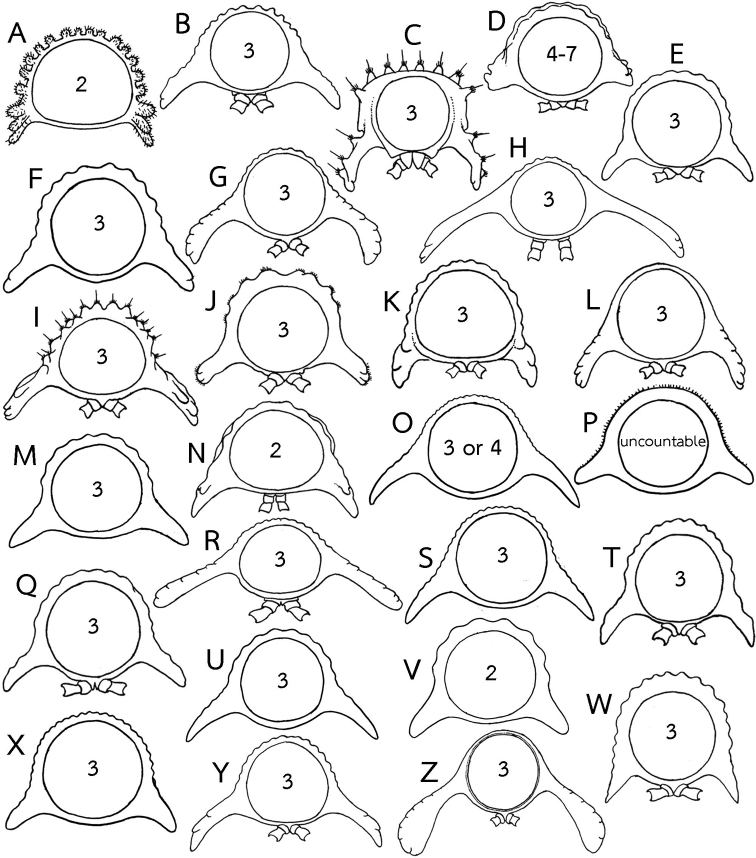
Body ring (posterior view) in several Eutrichodesmus species, number inside ring indicates rows of tubercles on metaterga. All species without mid-dorsal projections on metaterga AE.
elegansBE.
filisetigerCE.
gremialisDE.
griseusEE.
incisusFE.
jianjiaGE.
latellaiHE.
latusIE.
monodentusJE.
multilobatusKE.
nadanLE.
obliteratusME.
parvusNE.
peculiarisOE.
planatusPE.
reductusQE.
regularisRE.
similisSE.
simplexTE.
sketiUE.
spinatusVE.
taiwanensisWE.
tenuisXE.
triangularisYE.
troglobius and ZE.
trontelji. Not to scale. Figures modified from AMiyosi (1956)B, D, J, P, QGolovatch et al. (2009b)C Hoffman (1982) E, H, RGolovatch et al. (2009a)FLiu and Wynne (2019)G, L, T, W, X, Y, ZGolovatch et al. (2015)I Zhang inZhang and Wang (1993)KGolovatch et al. (2016)MLiu and Wesener (2017)NMurakami (1966)O, S, ULiu and Tian (2013) and VGolovatch et al. (2010).